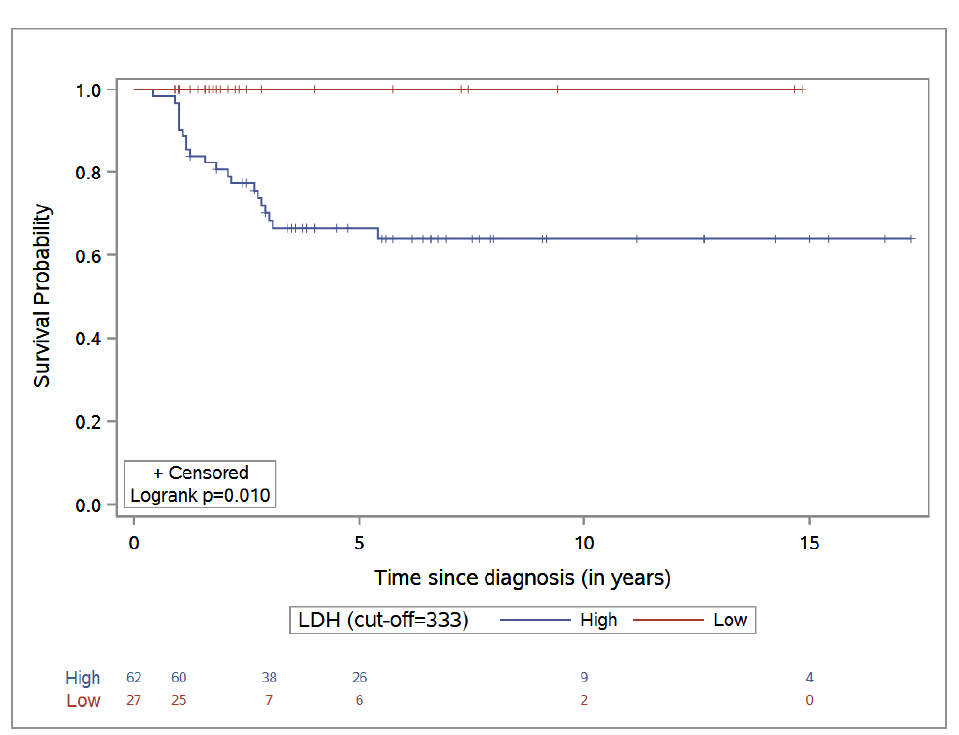
Figure 2. Overall survival stratified by LDH level.